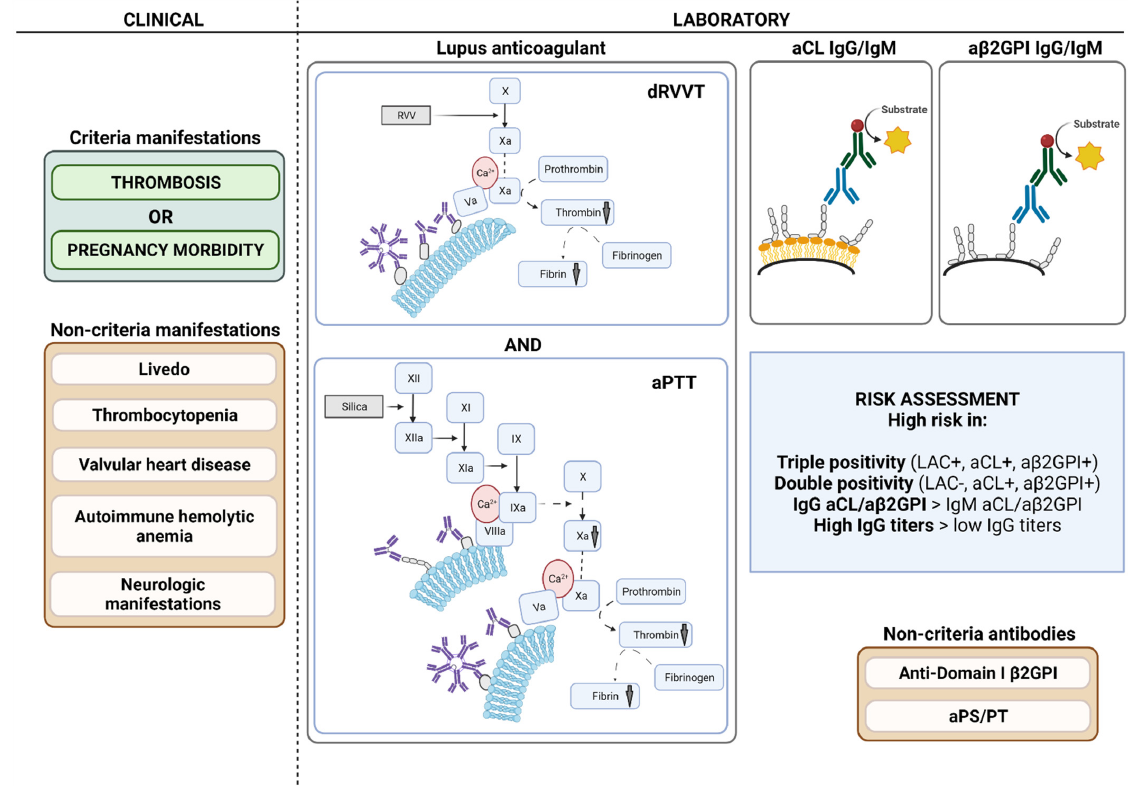
Figure 1. Diagnosis of APS is based on presence of at least one clinical criterion, whether or not accompanied by other non-criteria manifestations, and presence of at least one laboratory criterion over at least 12 weeks. Laboratory criteria consist of lupus anticoagulant (LAC), anticardiolipin (aCL) IgG/IgM antibodies, and anti- β 2 glycoprotein I (a β 2GPI) IgG/IgM antibodies. LAC is measured by applying two phospholipid-dependent coagulation tests, the diluted Russell’s viper venom time (dRVVT) and LAC-sensitive activated partial thromboplastin time (aPTT). The effect of LAC is schematically demonstrated. In dRVVT, factor X is directly activated by Russell’s viper venom (RVV), consequently activating prothrombin to thrombin in a phospholipid-, calcium-, and activated factor V-dependent way. Thrombin will further convert fibrinogen into fibrin, which can be detected mechanically or optically. In aPTT, factor XII is activated by a contact activator (silica) which initiates a sequence of activation of factor XI, IX, X, prothrombin, and conversion of fibrinogen to fibrin. Both activation of factors IX and X depends on phospholipids. Antiphospholipid antibodies present in the patient plasma sample will compete with coagulation factors for phospholipids through binding with phospholipid-bound cofactors such as β 2-glycoprotein I, resulting in a prolonged clotting time. Positive screening assays are followed by mixing and confirmation tests. In aCL assays, a solid phase is coated with cardiolipin which forms a complex with β 2GPI and a β 2GPI assays are coated with β 2GPI. Patient aCL or a β 2GPI can bind to the antigen on the solid phase. Subsequent binding of reagent anti-human IgG/IgM antibody labeled with conjugate leads to conversion of a substrate into a measurable product. Risk for clinical events is highest for patients with triple- and double-positive profiles. Higher risk is also observed for IgG aCL/a β 2GPI compared to IgM, and higher IgG titers are more associated with clinical events compared to lower positive titers. Non-criteria antiphospholipid antibodies such as anti-domain I β 2GPI IgG and antiphosphatidylserine/prothrombin antibodies are currently not part of the laboratory criteria, and are currently not advised to be measured in routine practice. Created with